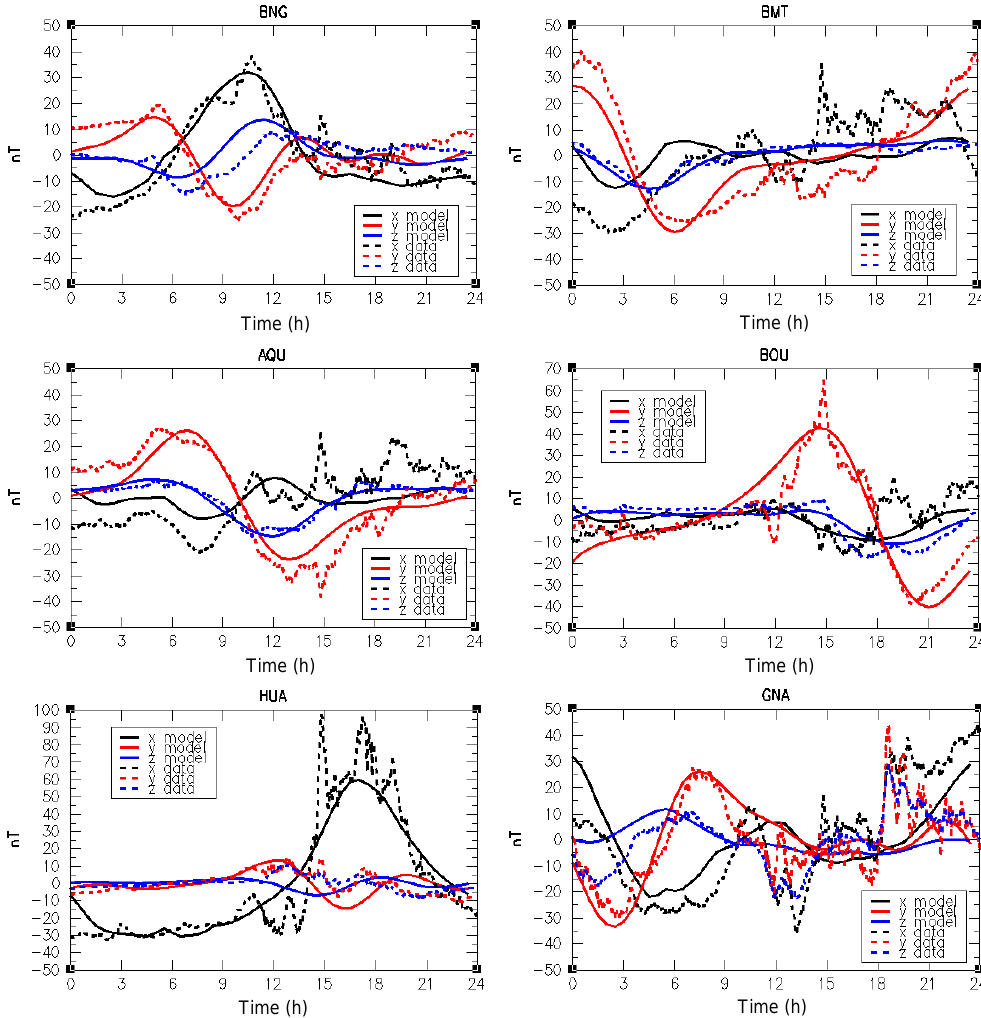
Figure 4. Same as in Fig. 3 but for moderately disturbed time (away from quiet time).